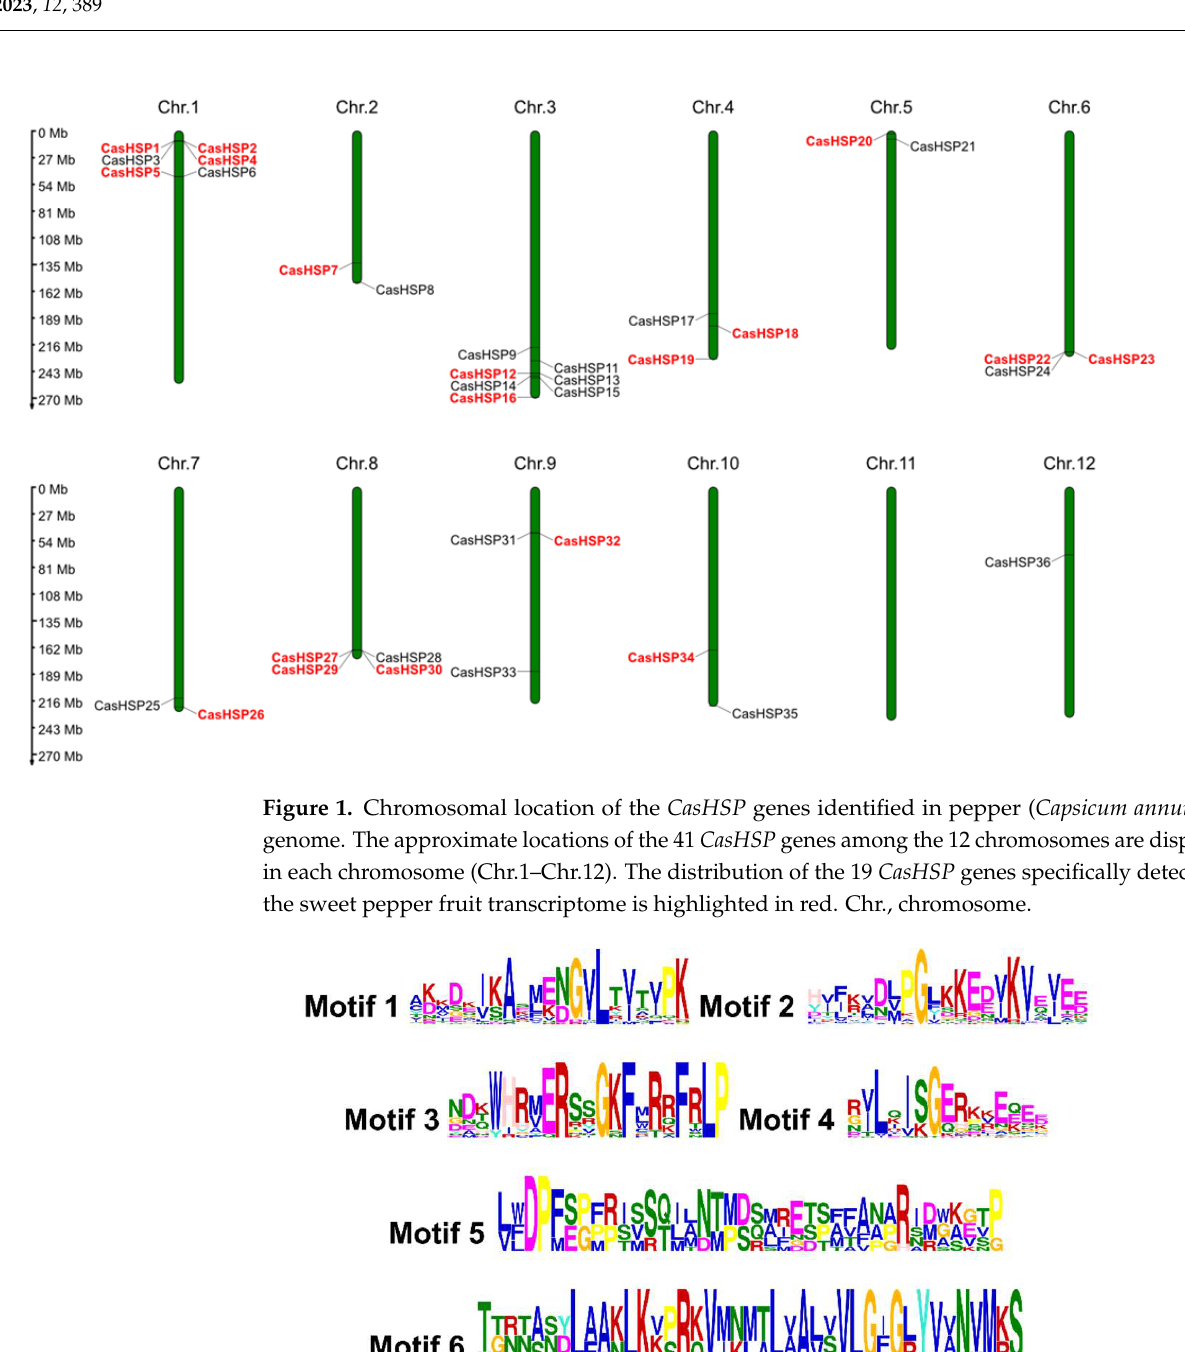
( b ) Figure 2. Identification and position of consensus amino acid motifs for pepper CasHSPs. ( a ) Amino acids motifs. Ten amino acid motifs with various widths were identified. The height of each amino acid symbol is proportional to the degree of conservation in the consensus sequences depicted in the ten motifs. ( b ) Distribution of conserved motifs. The distribution of conserved motifs, numbers 1–10, of the forty-one pepper sHSPs, are represented by boxes of different colors. Sequence logos of conserved motifs were created by MEME.